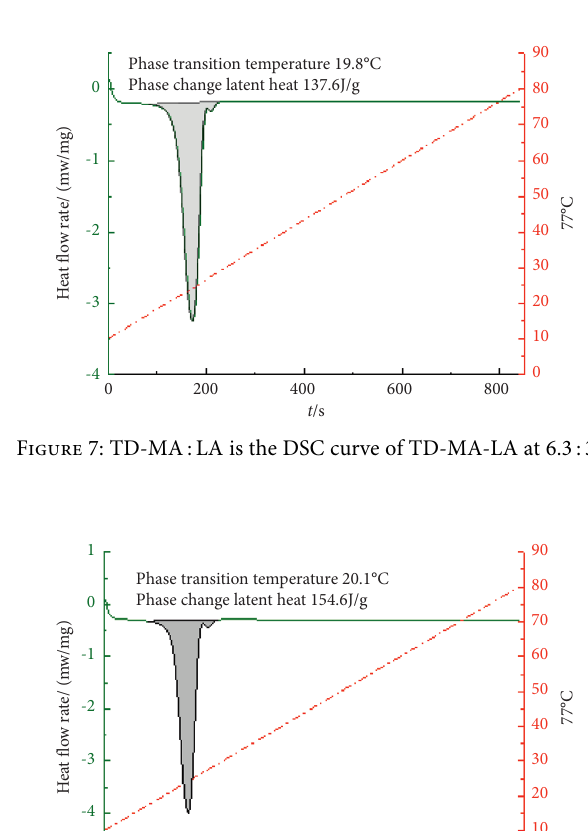
Figure 5: TD: MA is the DSC curve of TD-MA at 6.7:3.3. Phase transition temperature 34.8°C Phase change latent heat 198.4J/g